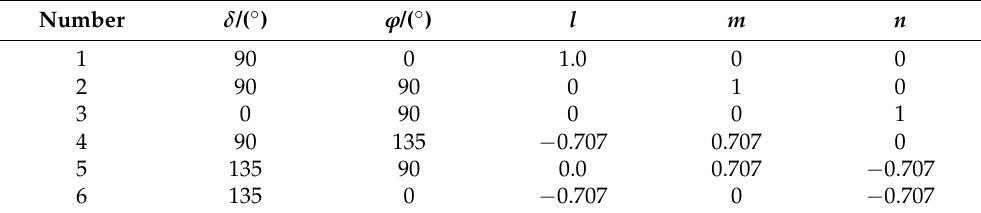
Table 2. The direction cosines of six strain measuring lines in different directions of a three- dimensional stress sensing